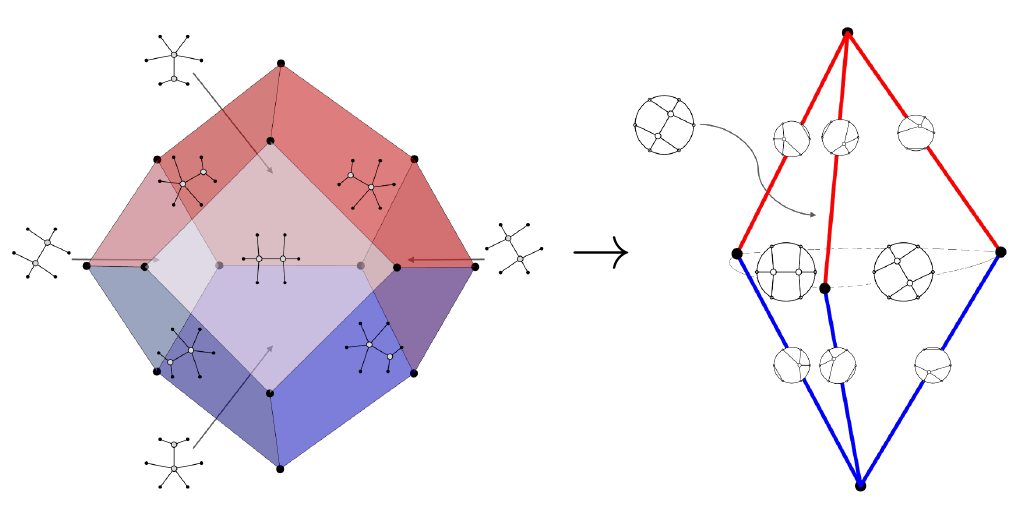
Figure 8 . Reduction of the three-dimensional associahedron to the orthogonal momentum ampli- tuhedron O 3